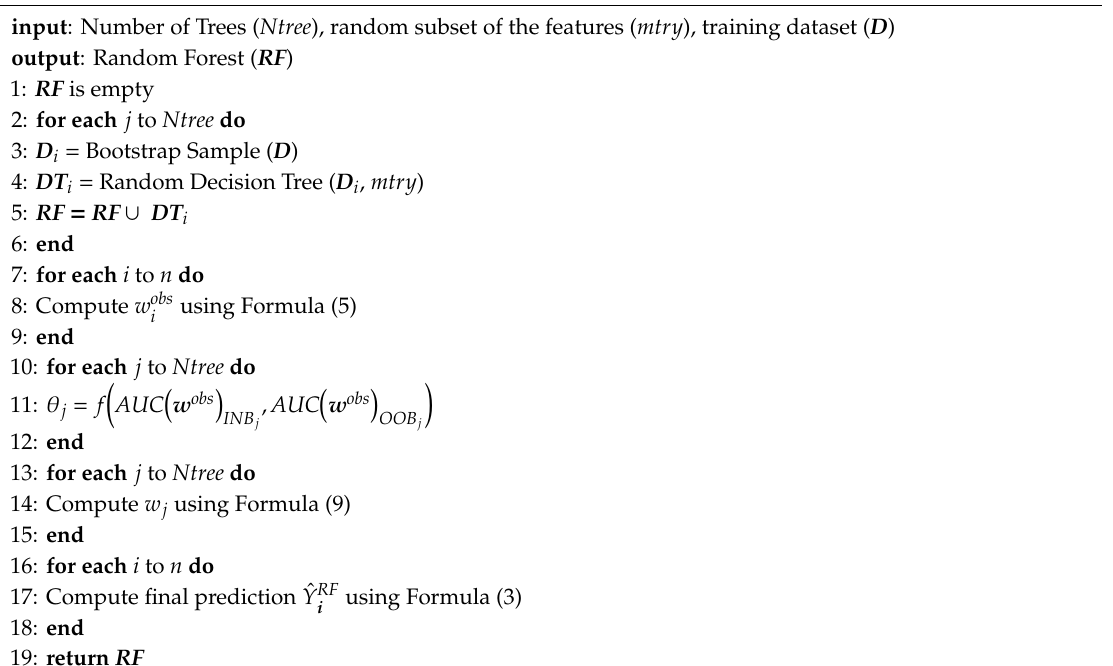
Algorithm 1. Weighted Random Forest algorithm